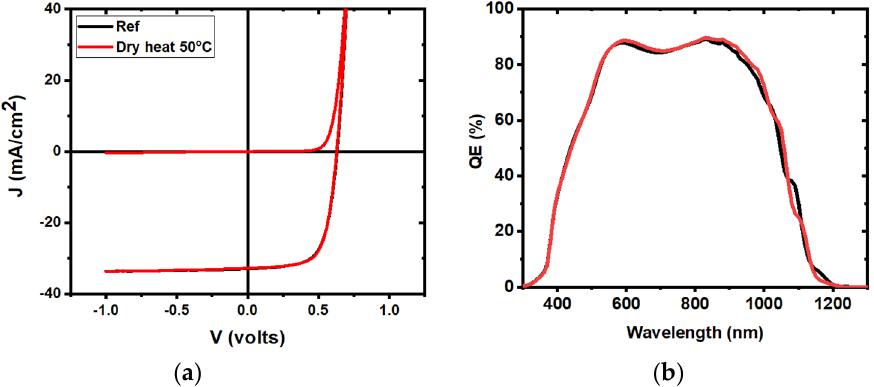
Figure 11. Representative J-V ( a ) and QE ( b ) curves for 5 mTorr samples heated in dry conditions at 50 °C (red curve), compared to reference samples (black curve).